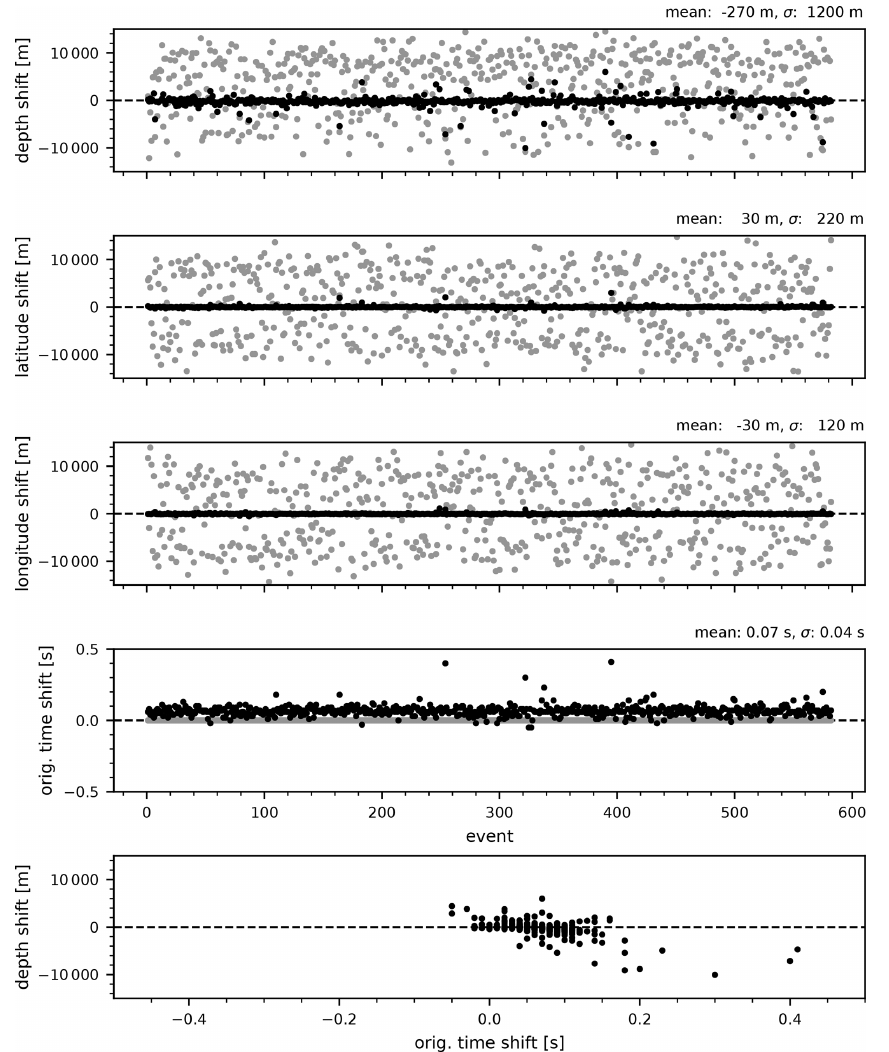
Figure 10. Pseudorandom hypocenter shift test. Hypocenters obtained with the MPS velocity model were shifted along pseudorandomly generated vectors by 10 to 15km (grey dots in the first three plots) and used as an input in another inversion run with nine iterations. Black dots show the resulting shifts in the hypocenter parameters remaining after this test. All shifts are referenced to hypocenter parameters obtained with the MPS velocity